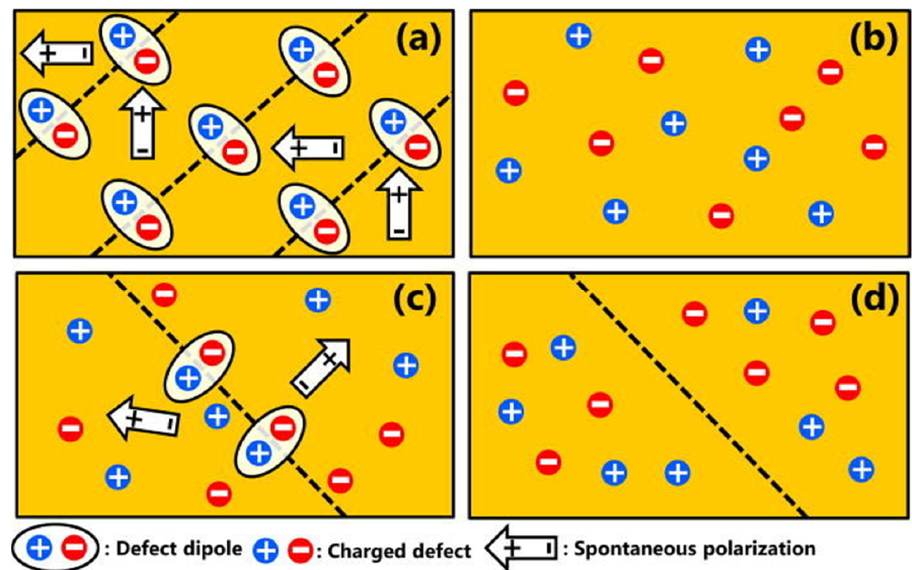
Figure 17. Schematic of defect structure in BiFeO 3 –BaTiO 3 ceramics; ( a ) as-sintered, ( b ) at high tem- perature, ( c ) furnace cooling after annealing, and ( d ) quenching after annealing. Schemes follow the same formatting. Reprinted with the permission of [135]. Copyright © 2017 AIP Publishing.